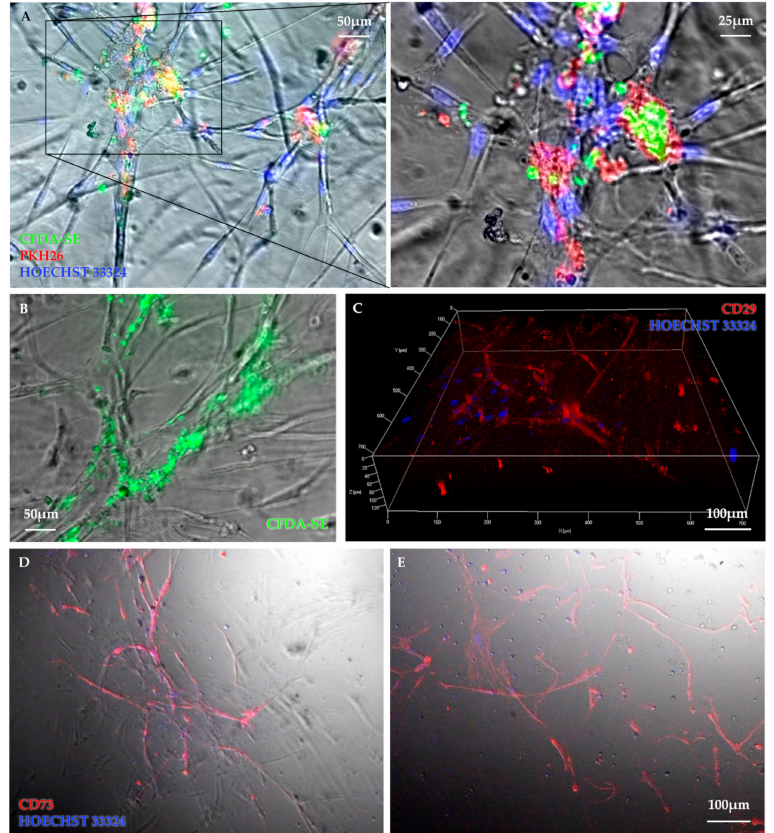
Figure 3. Representative images illustrate cellular interactions within the network structure. Colocalization of CFDA-SE labelled CD133 + cells (green) and PKH26-labelled CD271 + cells (red) at nodal points of the CD133 + / CD271 + cell co-culture angiogenesis assay but with very rare or no connections of CD133 + cell culture were observed ( A ). Although CD133 + cell cultures built minimal networks and true CFDA-SE fluorescent signal originate inside the network structures ( B ). 3D-image of a vital mesenchymal cell network was taken 2 weeks after seeding ( C ). CD271 + cell ( D ) as well as CD133 + / CD271 + cell co-culture ( E ) angiogenesis assays were stained with CD73-PE antibody (red) and counterstained for nuclei with Hoechst dye